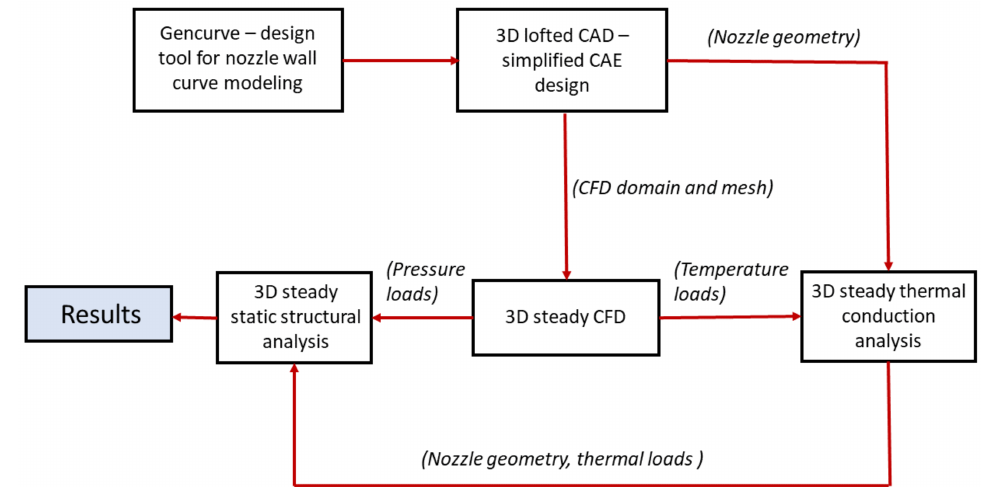
Figure 5. One-way coupled Fluid–Thermal–Structural Interaction (FTSI)